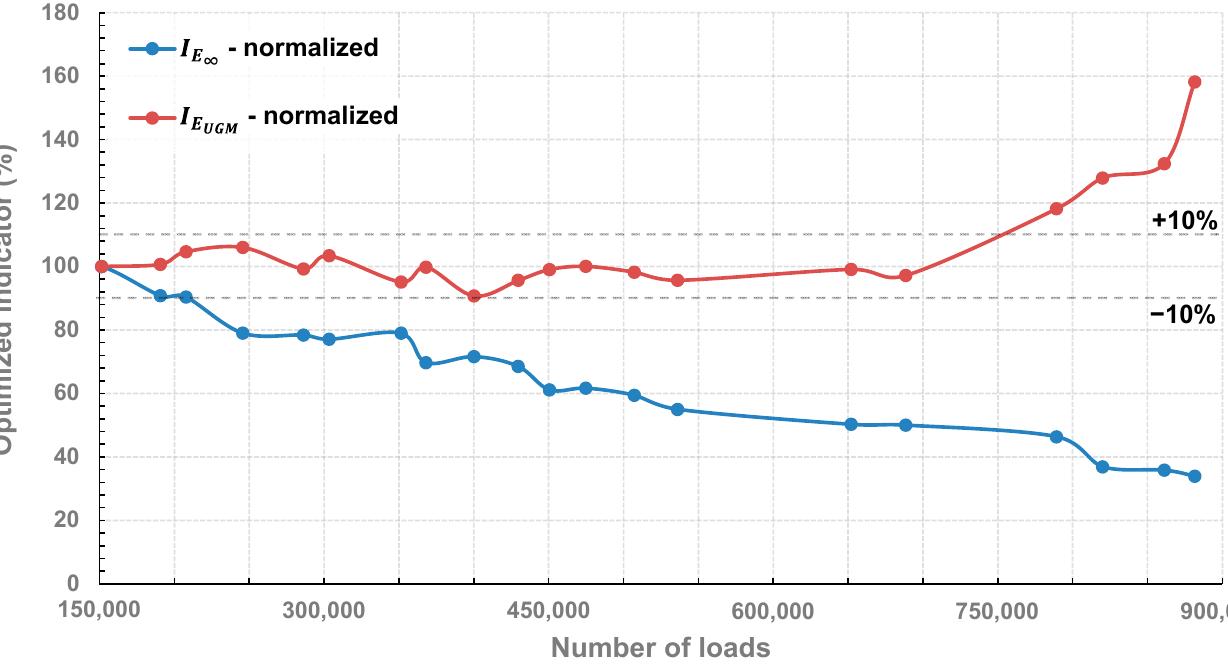
Figure 12. Relative evolution of the optimized indicators with the number of loads.